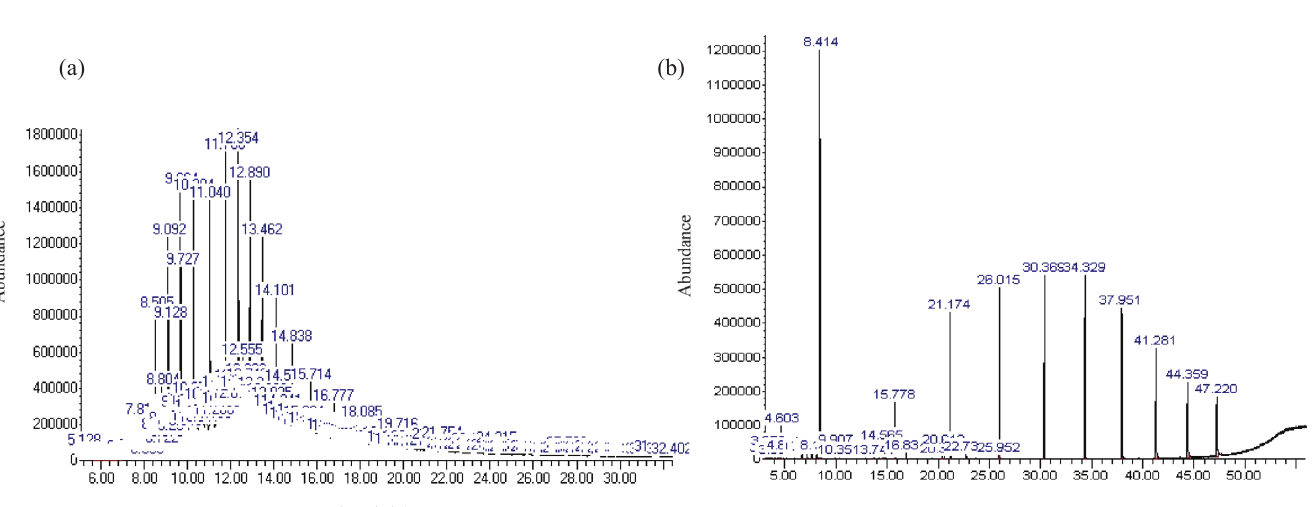
Fig. 7 – GC-MS analysis of a) unwashed hydrocarbon-contaminated soil, and b) hydrocarbon-contaminated soil after remediation with persulfate-assisted EK remediation under the selected conditions (Tween 80: 20 mL kg –1 , initial pH: 7 ± 0.3, reaction time: 24 h,